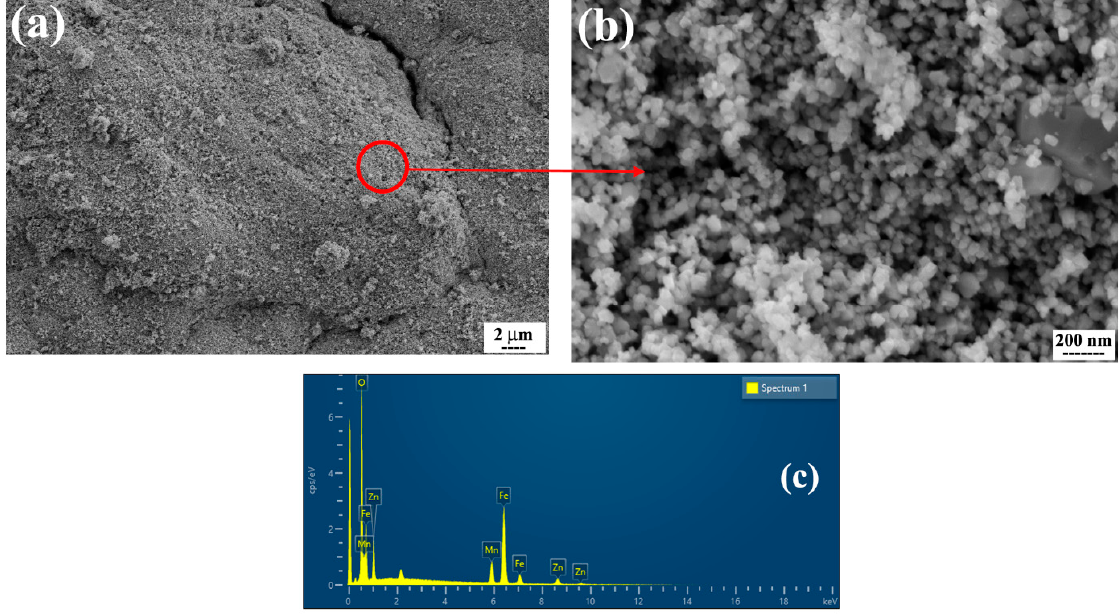
Figure 2. ( a , b ) SEM micrographs of synthesized MnZn ferrite with normal morphology at different magni fi cations, and ( c ) corresponding EDS results.